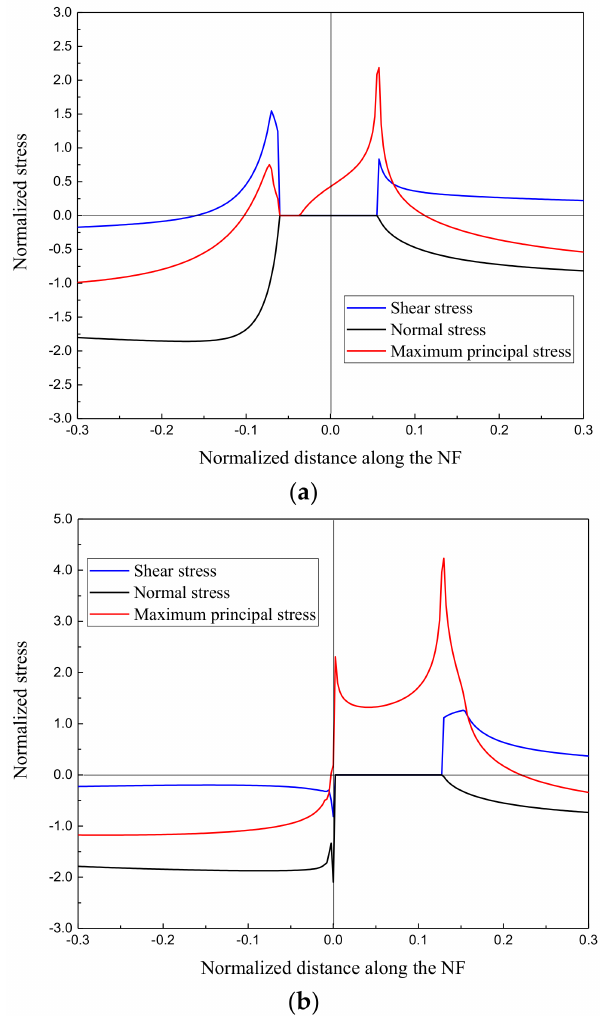
Figure 10. Normalized stresses along the NF. ( a ) Fractures gap ρ = 0.1 m; ( b ) Fractures gap ρ = 0.0 m.